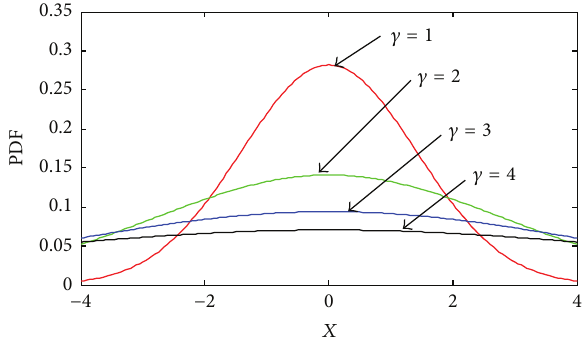
Figure 2: PDF of stable distribution with different 𝛾 values (𝛼 = 2, 𝛽 = 0, 𝛿 = 0) .